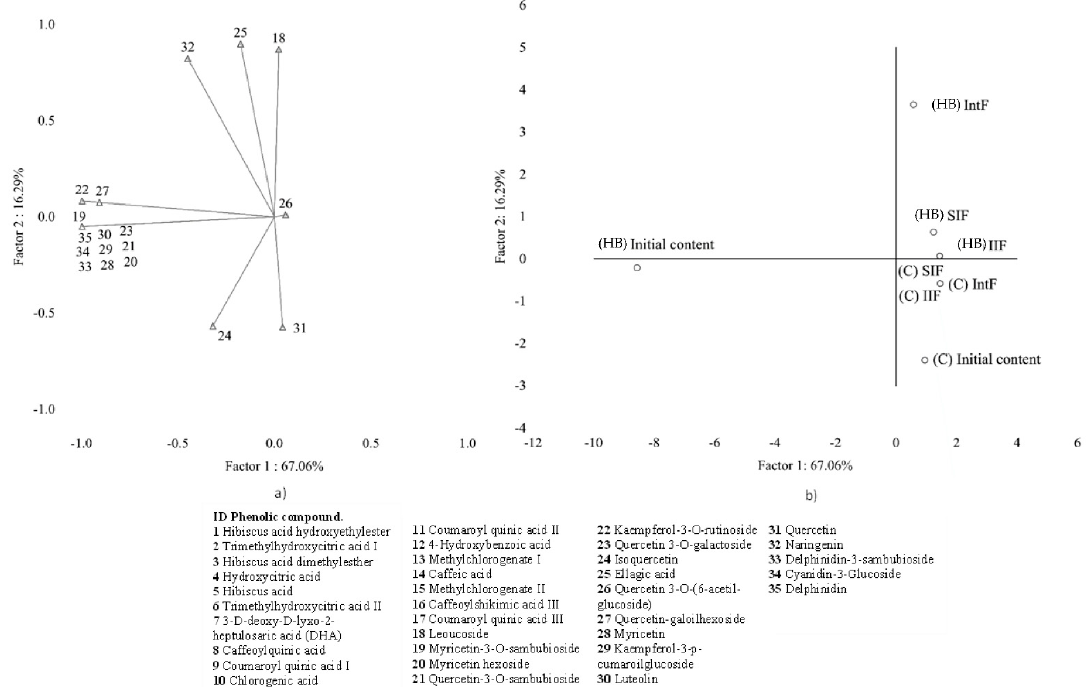
Figure 2. Analysis of flavonoids patterns by group found in the extracts from “initial content” and during in vitro gastrointestinal digestion of commercial (C) and Hibiscus beverage (HB) using prin- cipal component analysis (PCA): ( a ) Projection of the variables on the factor-plane, ( b ) projection of the cases on the factor-plane. PC2 on the positive axis was highly influenced by glycosides such as leucoside, and aglycones such as ellagic acid, and naringenin (ID: 18, 25, 32). On the other hand, PC1 negative axis comprises compounds that were quantified at relatively low levels (ID: 19, 20, 22, 28, 29, 30, 33, 34, 35). However, these compounds improve the profile of BC in the hibiscus beverage.